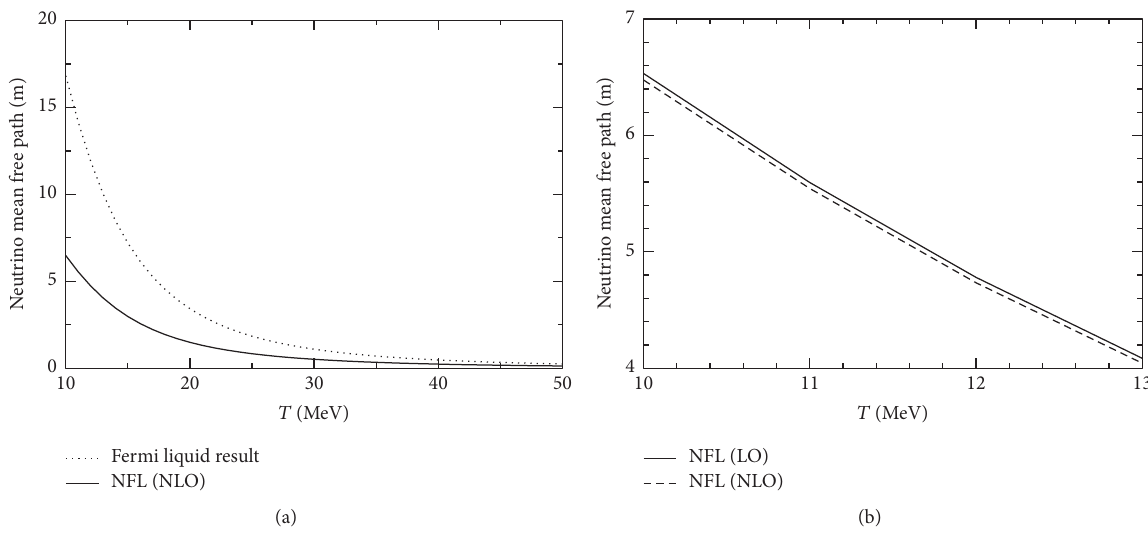
Figure 1: Mean free path of degenerate neutrinos. A comparison between the FL result and NLO corrections for the NFL effects has been shown in (a). The reduction of the MFP due to NLO corrections has been shown in (b).